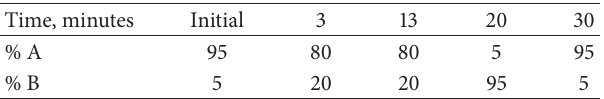
Table 1: Gradient